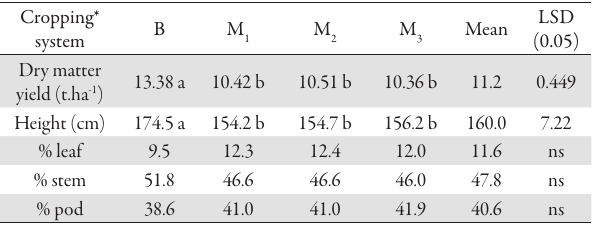
Tab. 4. Effect of different cropping system on bean